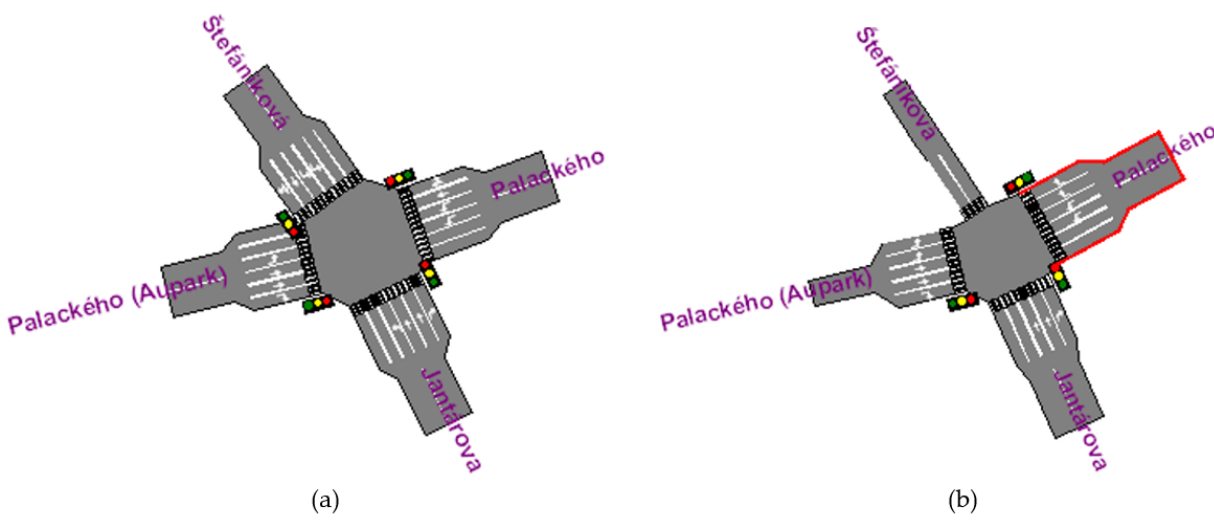
Figure 7. Model of intersection Palackeho–Jantarova for Variant A ( a ) and Variants B and C ( b ), (source elaborated by authors).